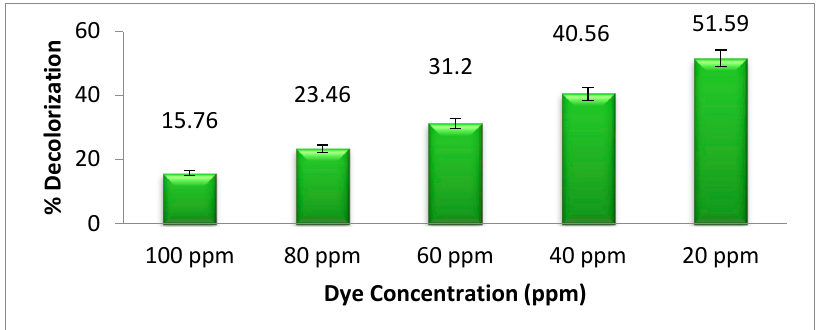
Figure 3. Effect of dye concentration on methyl orange degradation.